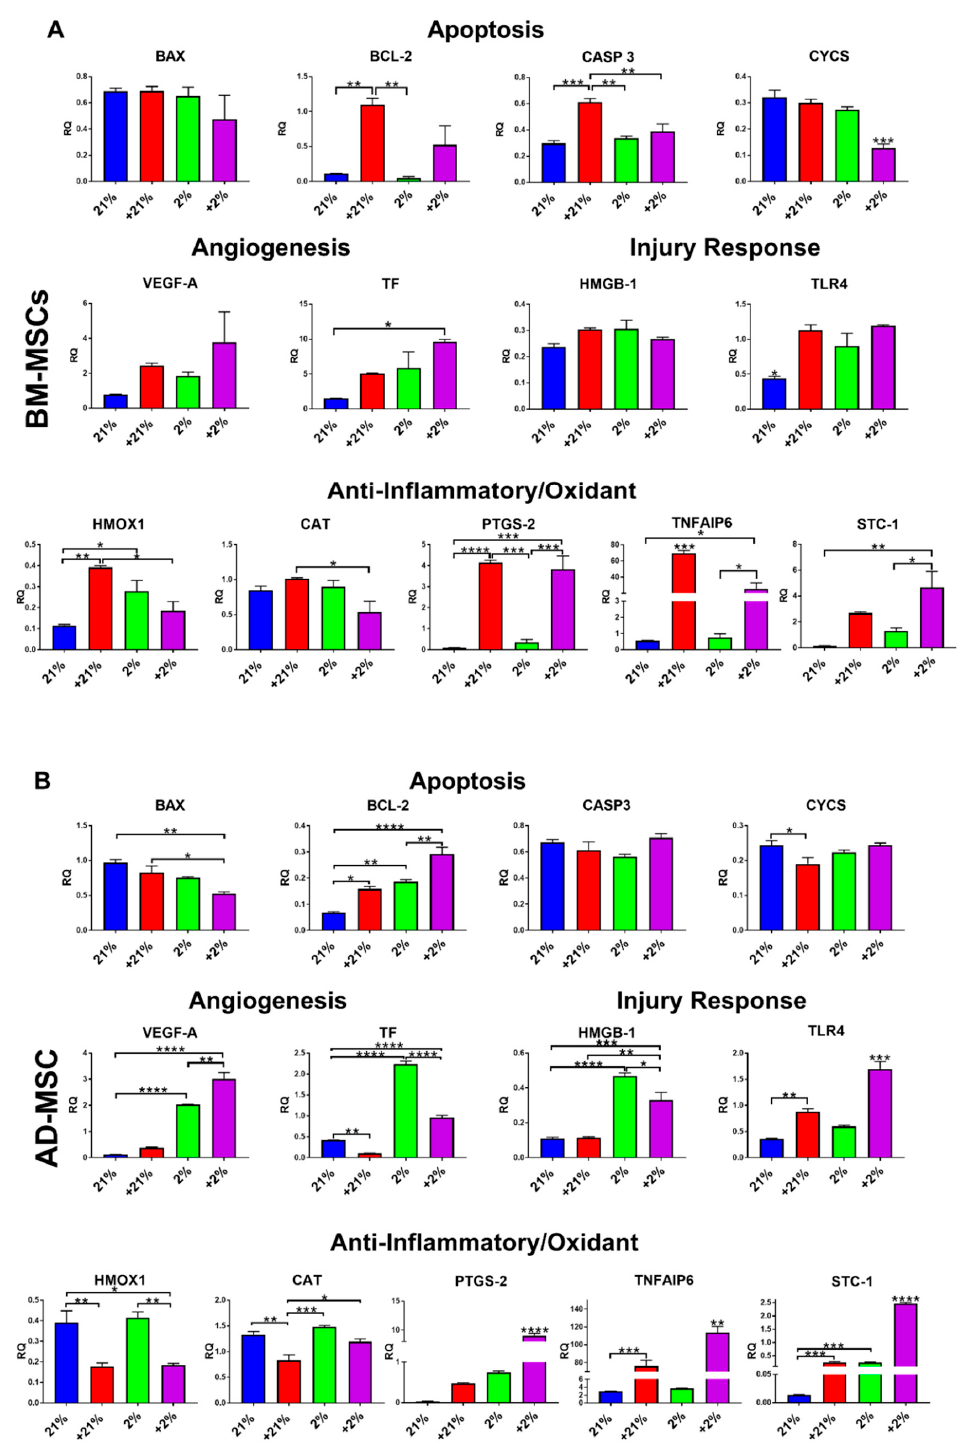
Figure 3. Gene expression of preconditioned MSCs. ( A ) In BM-MSCs, Cytomix-normoxia treatment significantly upregulated gene expression of BCL-2 , CASP-3, CYCS , TLR-4 , HMOX1 , PTGS-2 , and TNFAIP6 . Hypoxia preconditioning increased TLR-4 and HMOX1 gene expression, while Cytomix-hypoxia combination significantly upregulated TLR-4 , PTGS-2 , TNFAIP6 , and STC-1 and downregulated CYCS . ( B ) In AD-MSCs, Cytomix-normoxia treatment significantly upregulated gene expression of BCL-2 , TLR-4 , and TNFAIP6 . Hypoxia preconditioning increased BCL-2 , VEGF-A , HMGB-1 , CAT , STC-1 , and HMOX1 gene expression, while Cytomix-hypoxia treatment significantly upregulated BCL-2 , VEGF-A , TF , HMGB-1 , TLR-4 , PTGS-2 , TNFAIP6 , and STC-1 and downregulated HMOX1 . * p < 0.05, ** p < 0.01, *** p < 0.001, **** p <